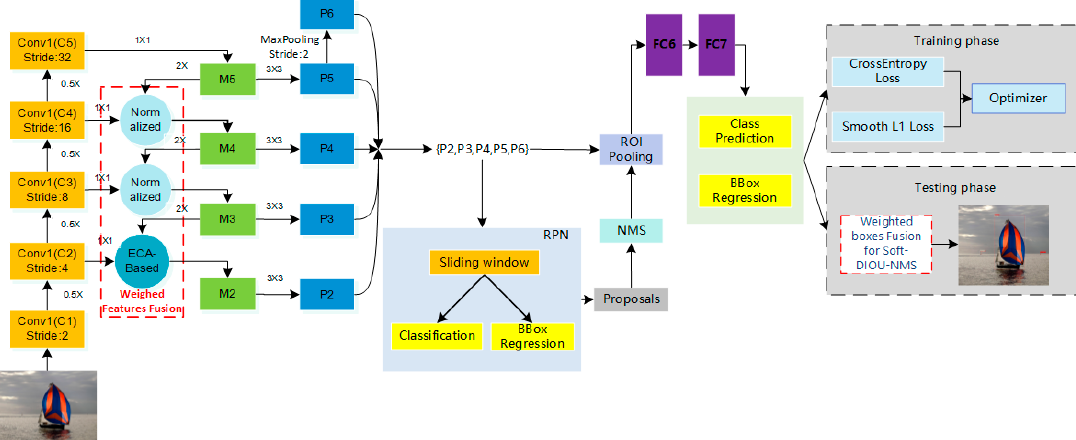
Figure 1. Architecture of SR-CNN for ship detection.